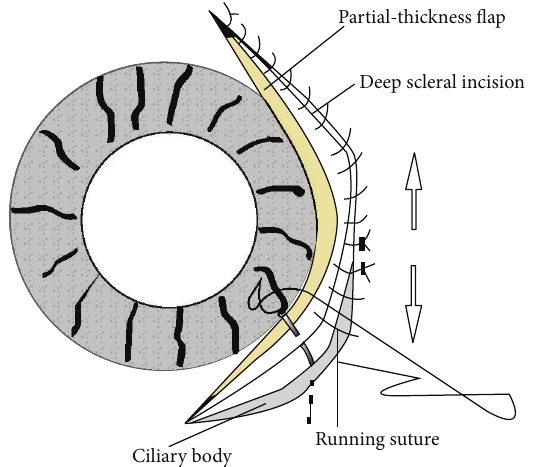
Figure 3: Deep scleral incision and running suture. A half of deep scleral incision is first made from the middle toward the end of the cleft and then closed with a running suture also starting from the middle to the end of the cleft. The same procedure is followed for the other half of the cleft (arrows show the direction of the